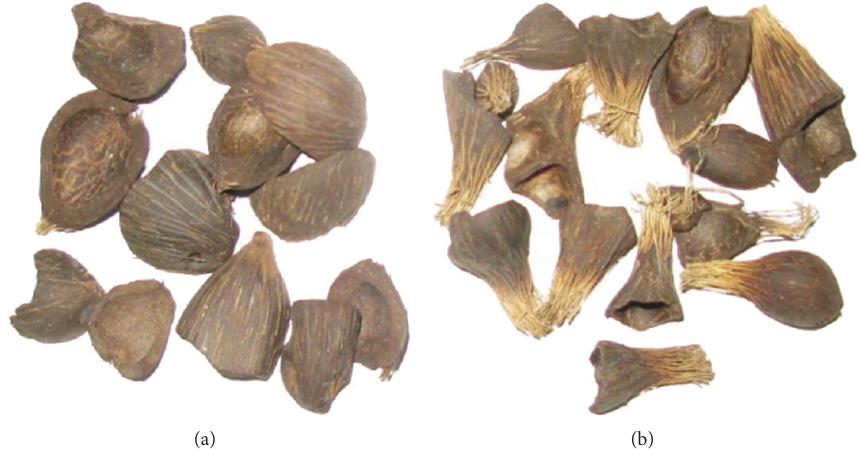
Figure 4: (a) Old OPS without fibres. (b) Fresh OPS with fibres.